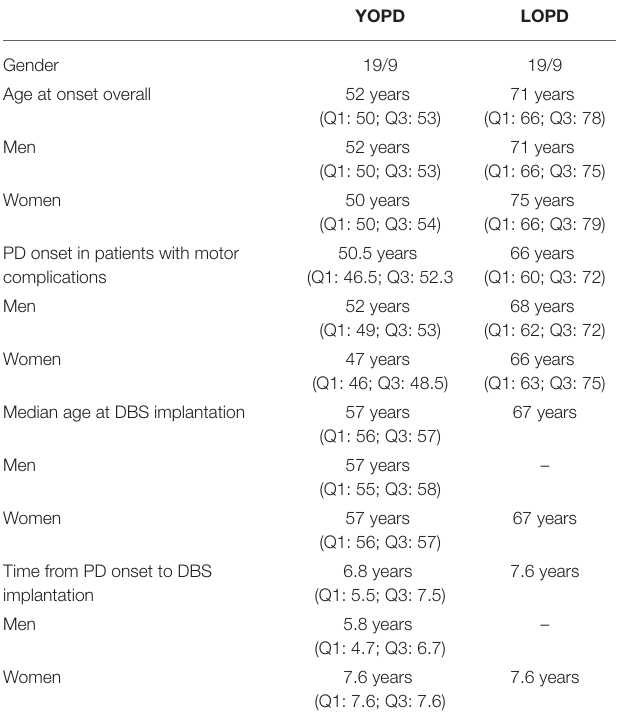
TABLE 1 | Demographic